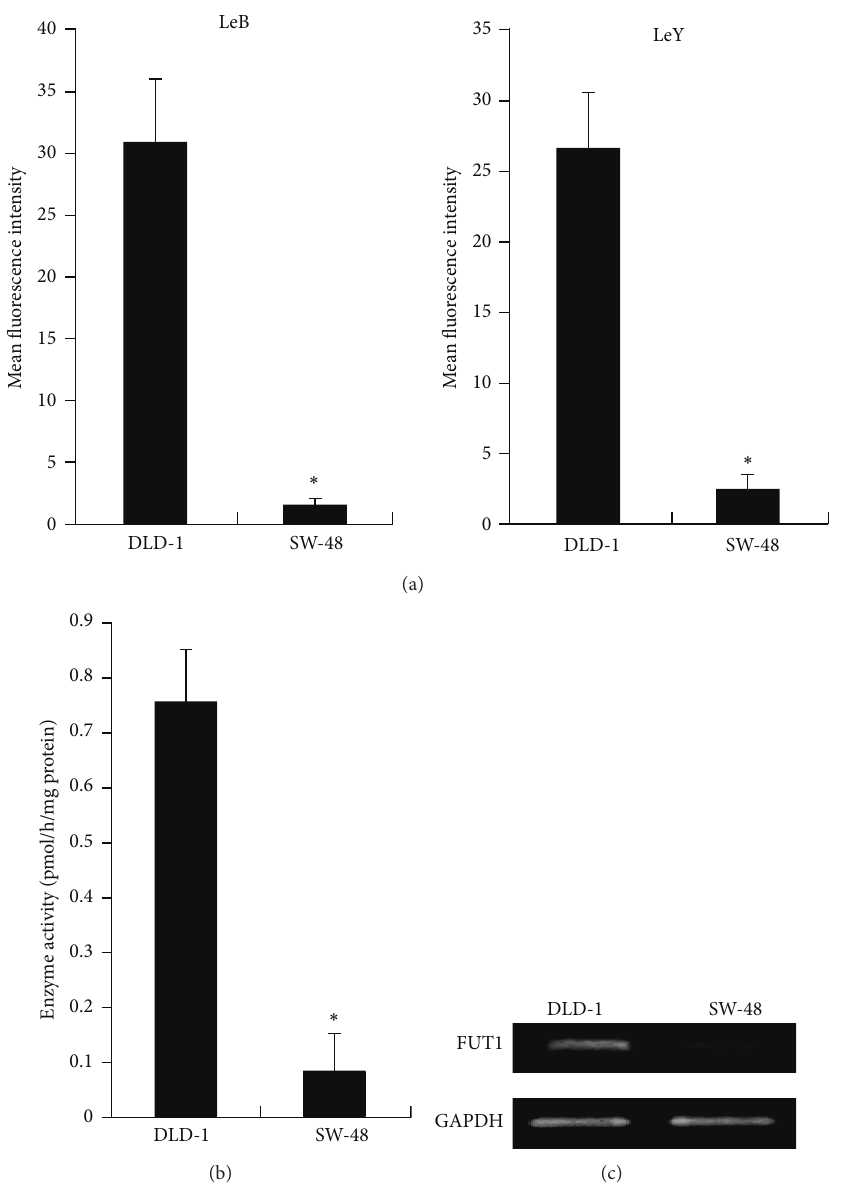
Figure 1: Expression of Lewis B/Y antigens, 𝛼 1,2-FUT activities, and FUT1 mRNA in SW48 and DLD-1 cells. (a) Lewis B and Lewis Y antigens on the surface of SW48 and DLD-1 cells were determined using flow cytometry. (b) 𝛼 1,2-FUT activities were determined by HPLC using fluorescent substrate Gal 𝛽 1,4GlcNAc-CM. (c) FUT1 mRNA expression levels were determined by RT-PCR. The results were obtained in three independent experiments and data represent mean ± SD. Asterisks indicate significant differences ( 𝑃 < 0.05